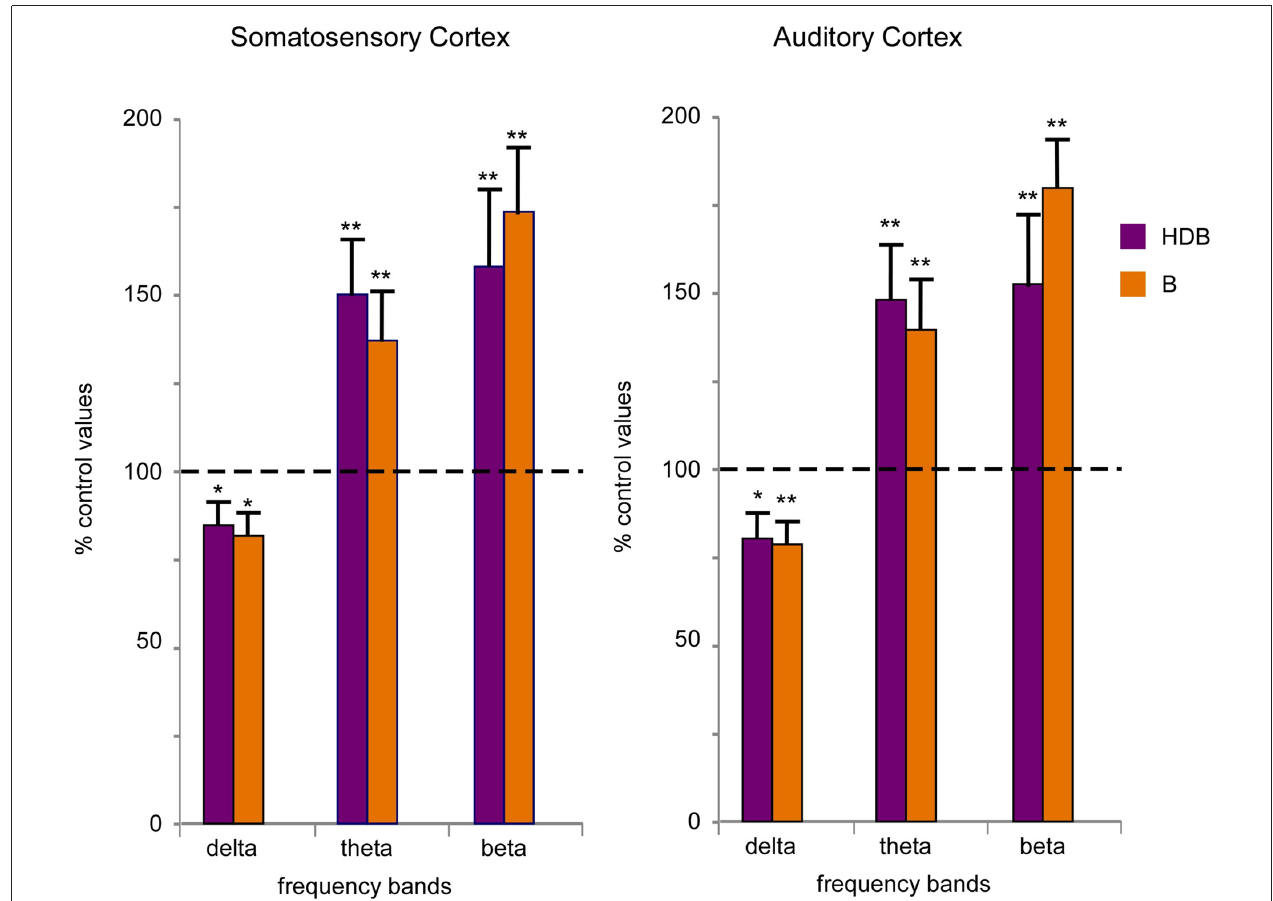
FIGURE 6 | Blue light stimulation of BF neurons induces fast activity in the cortical field potentials . Plots of the percentage of change in the frequency band of 30 s of EEG recording respect to 30 s of a control period (100%) in the S1 and A1 cortices (left and right plots, respectively). Blue light stimulation of the HDB or B nuclei reduced the percentage of delta activity (0.5–4 Hz) and increased theta (4–10 Hz) and beta (10–30 Hz) activity during 30 s after light